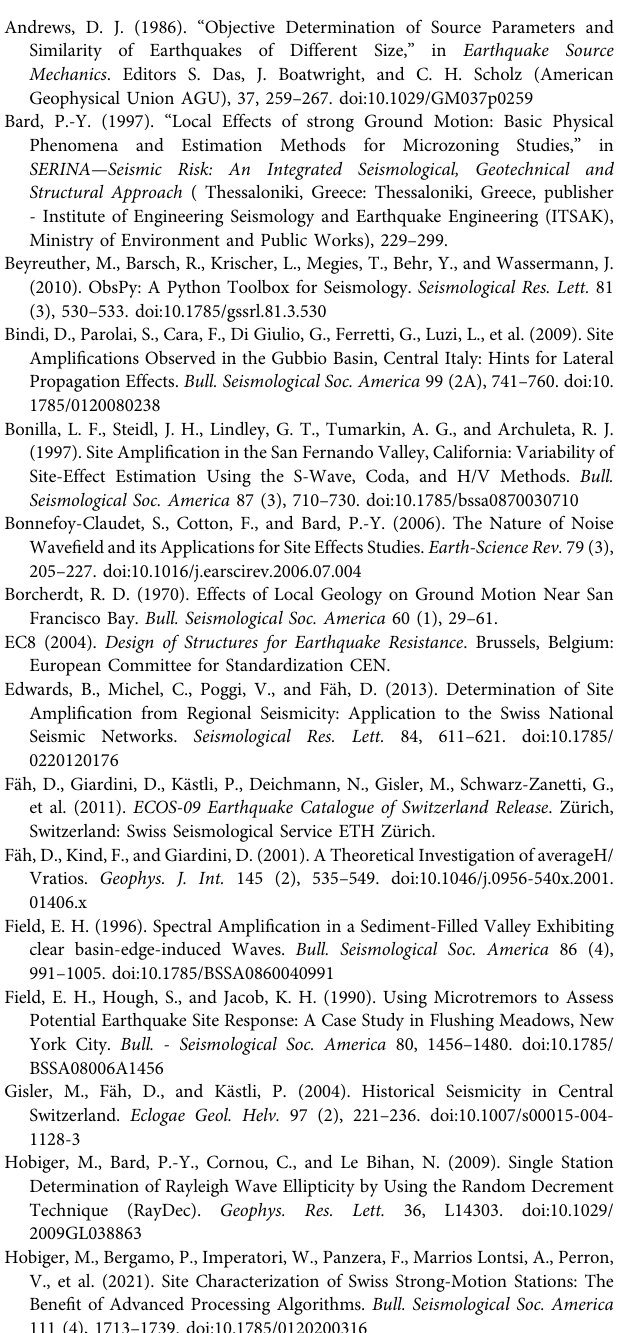
Supplementary Video S1 | Ampli fi cation factors with respect to the rock station LUZ01 derived using the SSRh method forthe Lucerne area forthe frequencyrange between 0.2 and 20 Hz. The ampli fi cation functions for stations of the temporary network are shown outside the map. Supplementary Video S2 | Ampli fi cation factors with respect to the Swiss reference rock pro fi le derived using the SSRh method for the Lucerne area for the frequency range between 0.5 and 20 Hz. The ampli fi cation